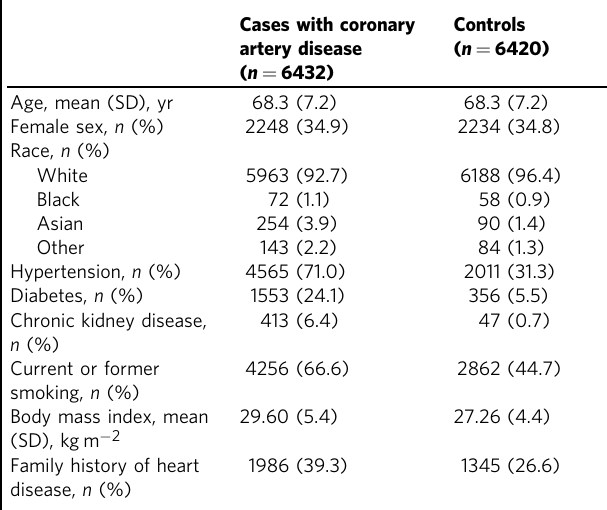
Table 1 Baseline characteristics of coronary artery disease case-control study